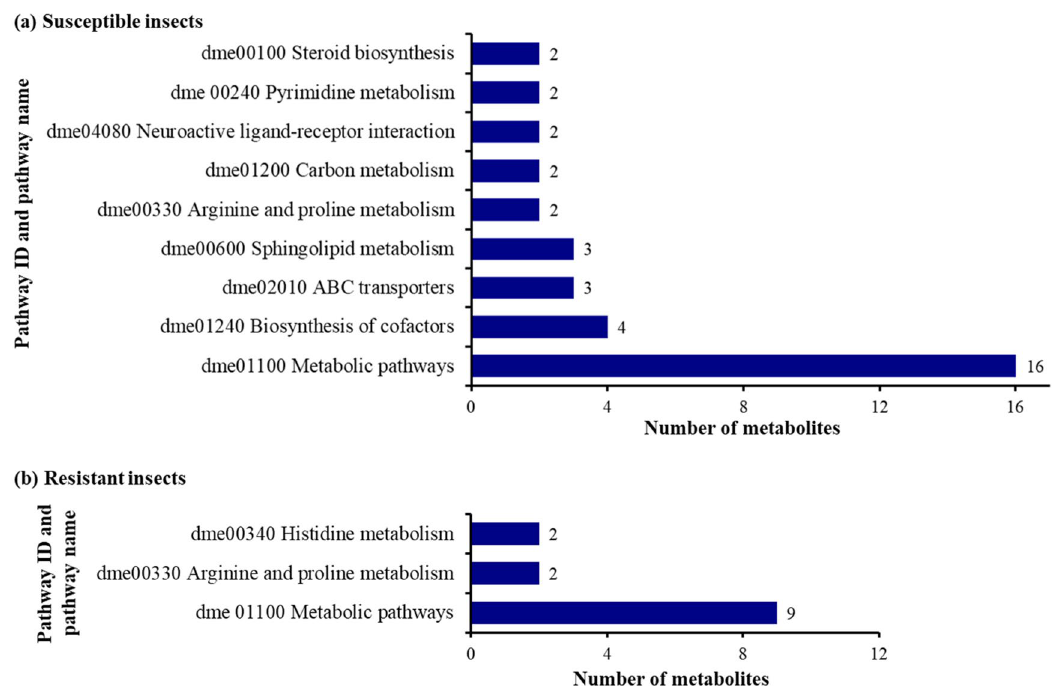
Figure 4. KEGG pathway analysis of differences in the identified metabolic pathways in susceptible ( a ), and resistant ( b ) western corn rootworm larvae fed on Bt-expressing maize seedlings (metabolite numbers ≥